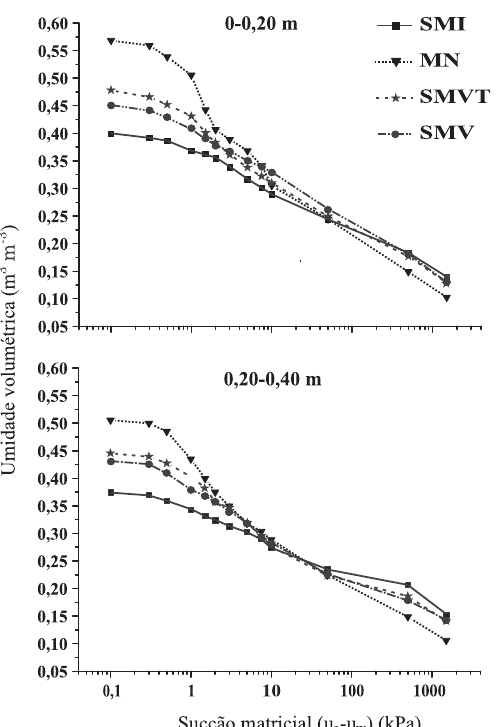
figura 1. Curvas características do solo sob os sistemas de manejo: área irrigada (smi), mata nativa (mN), área de vinhaça+torta (smVt) e área de vinhaça (smV), nas profundidades de 0–0,20 e 0,20–0,40